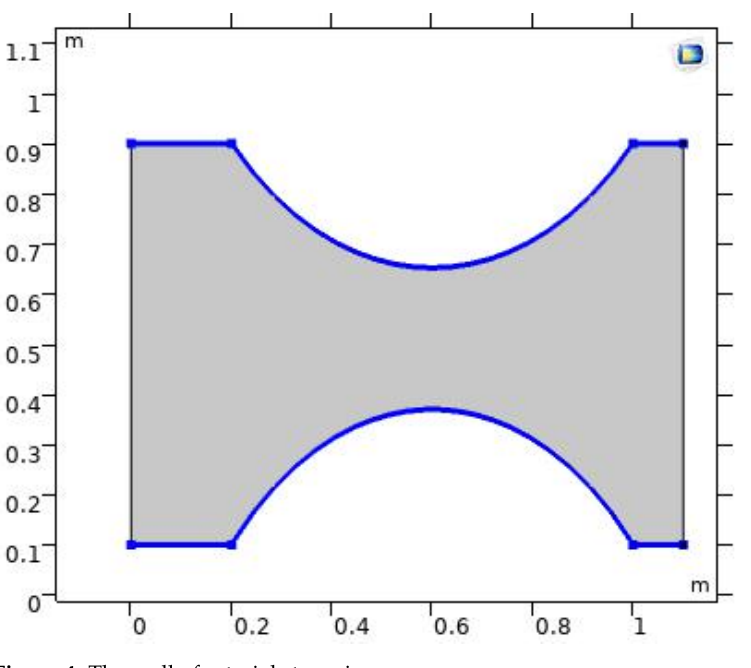
Figure 4. The wall of arterial stenosis.